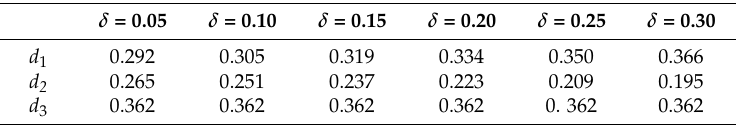
Table 7. Changes of desirability function values according to the rate of relaxation ( h = 1).